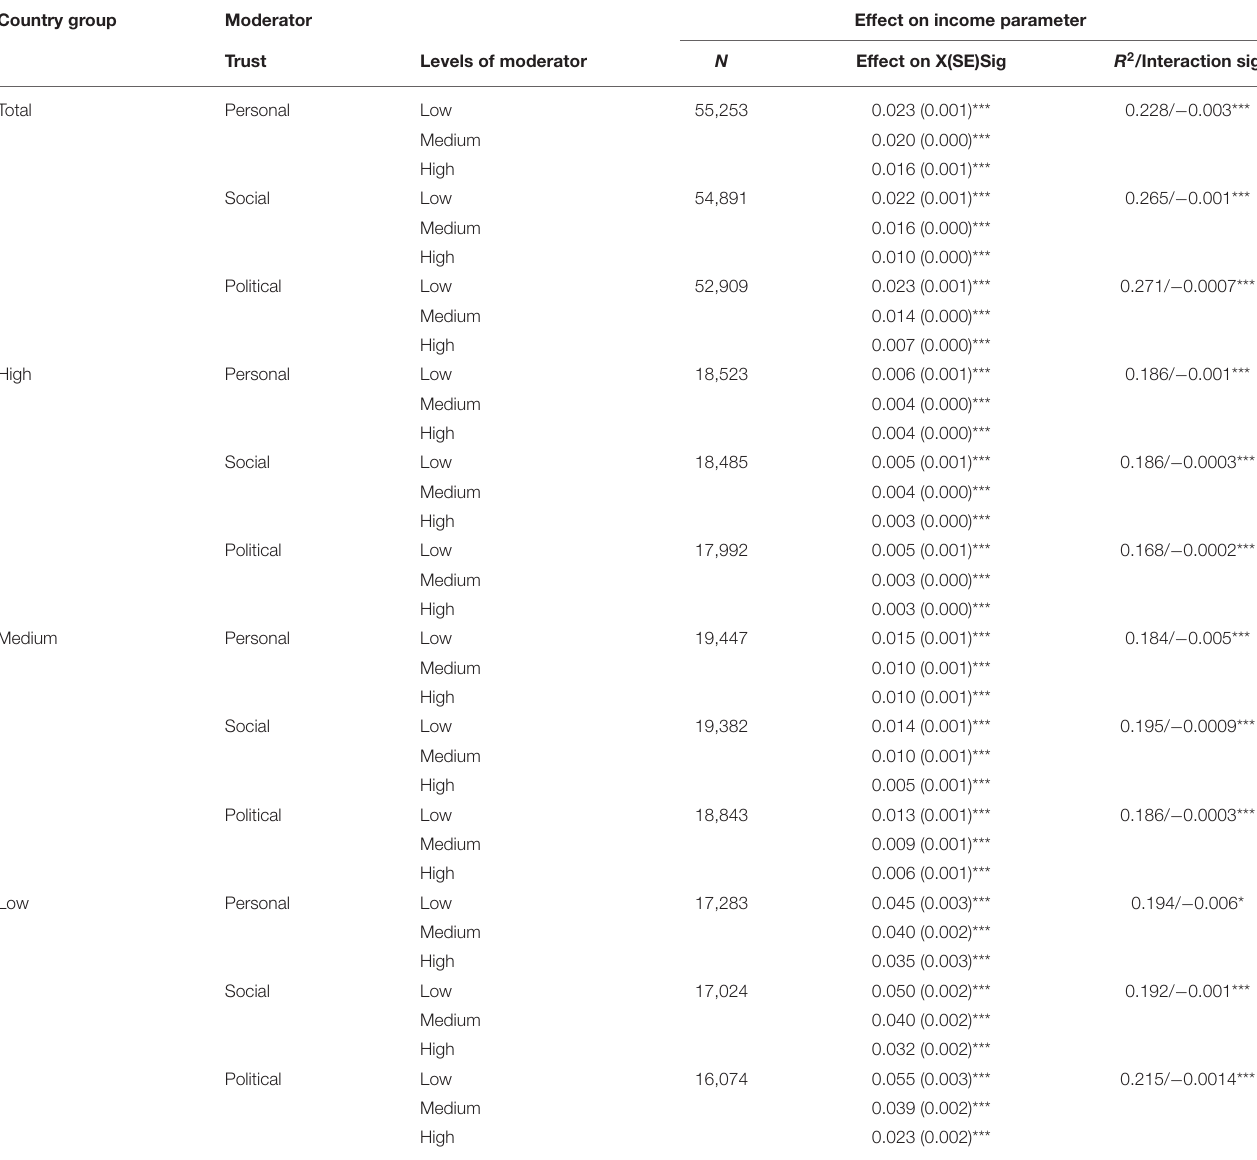
TABLE 5 | Results of moderation analysis (using Hayes PROCESS, which does not allow multilevel) for the moderator role of personal, social and political trust for X = personal income and Y = PLS, by country group as defined by overall trust and for the overall population. Country